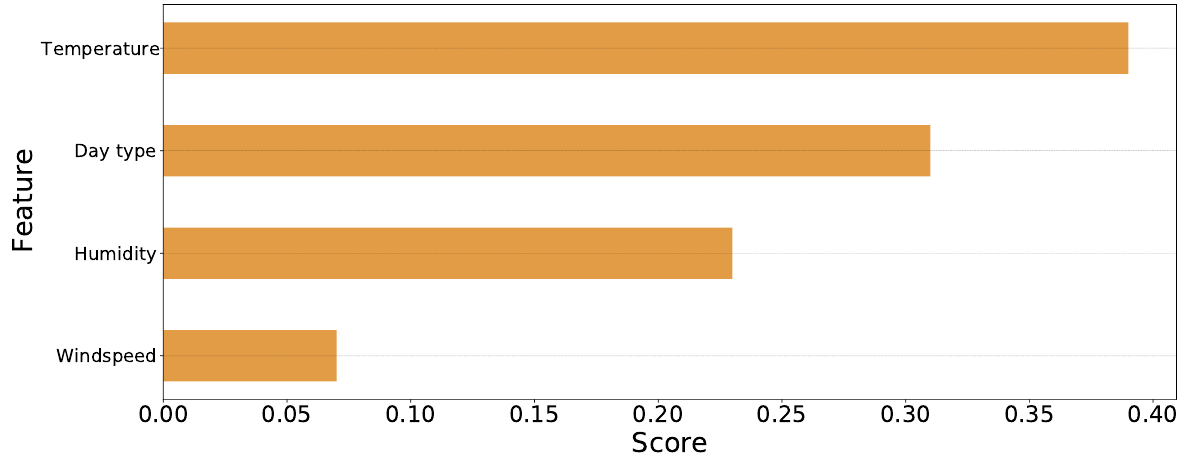
Figure 5. The relevance score of each